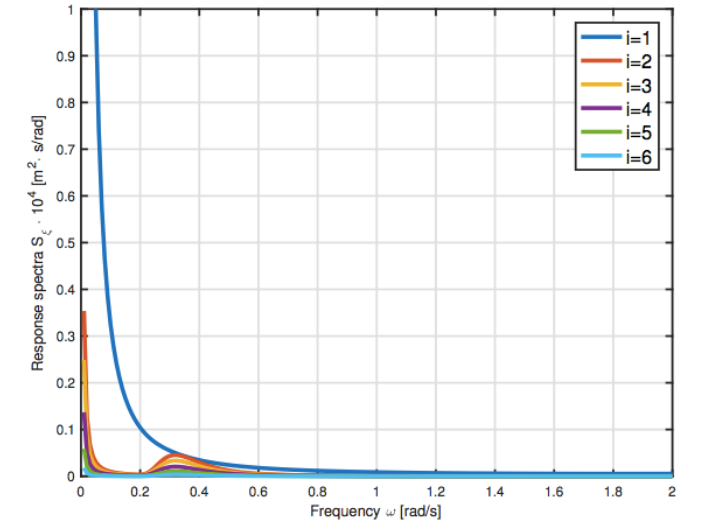
Figure 21. Response spectra for the displacements in physical coordinates of the offshore wind turbine mooring line